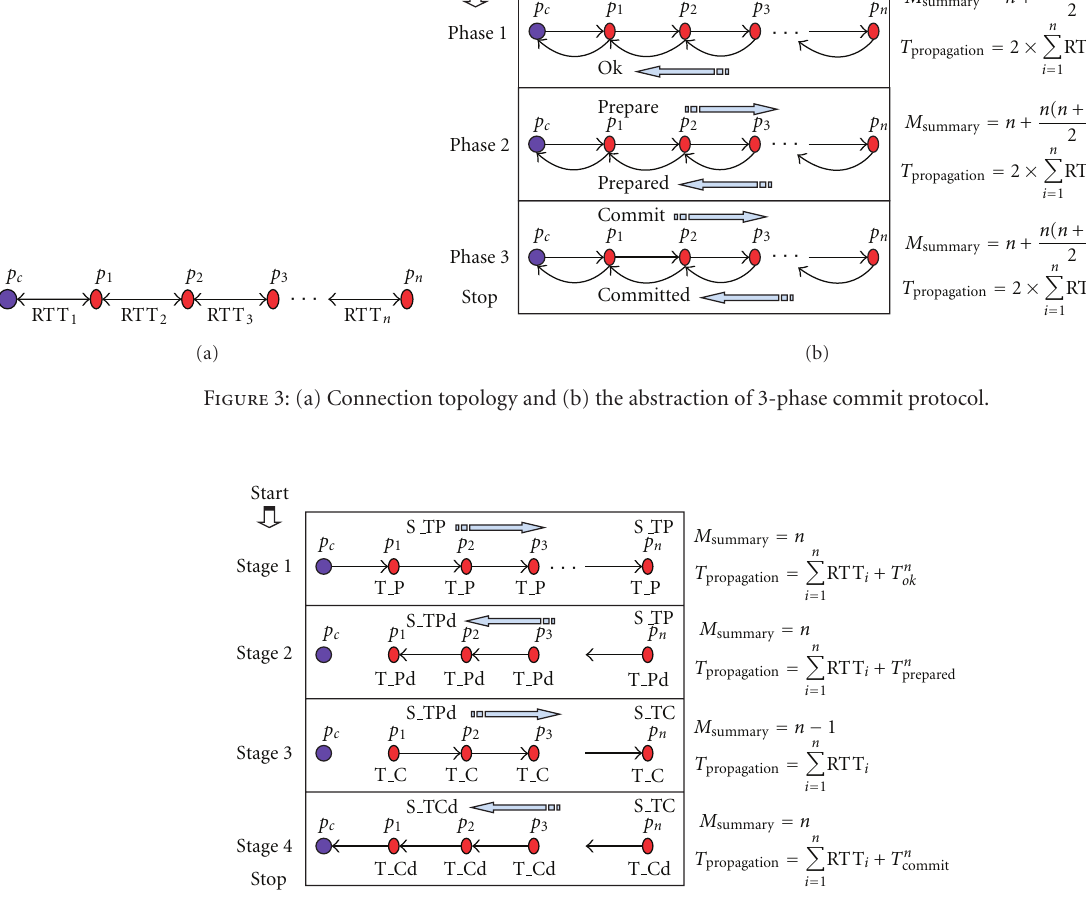
Figure 4: The abstraction of our